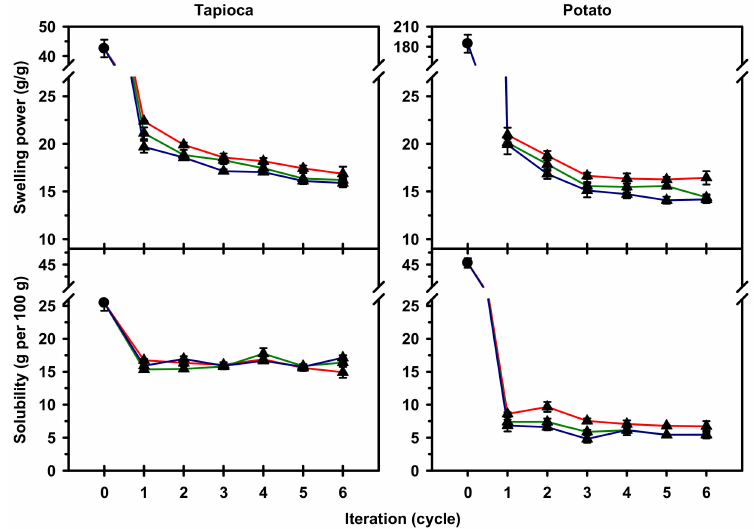
Figure 4. Swelling power and solubility of native ( • ) and heat–moisture treated ( (cid:78) ) starches with 0 ( — ), 30 ( — ) or 60 ( — ) min holding time and 1–6 iterations. Analyses were performed in